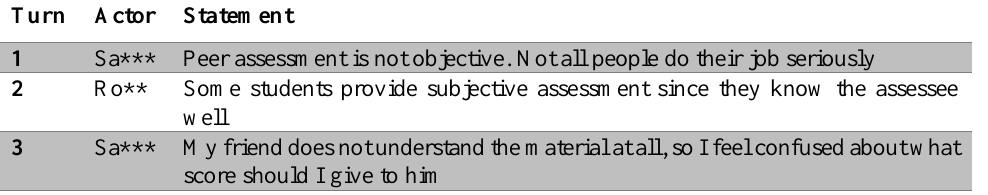
Table 6. The objectivity of peer assessment